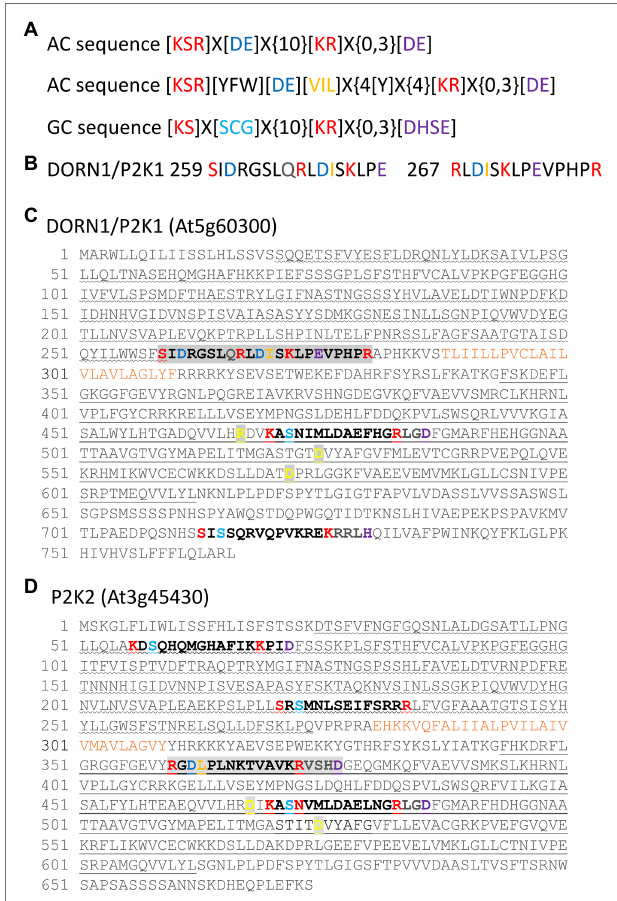
FIGURE 1 | Putative AC and GC sequences in the extracellular ATP (eATP) receptors DORN1/P2K1 and P2K2. (A) Top: The ACPred AC prediction tool sequence (Xu et al., 2018b). “X” denotes any amino acid, and “{}” denotes the number of undetermined amino acids. Centre: The AC catalytic center sequence used by Al-Younis et al. (2021). Bottom: The GCPred GC prediction tool sequence (Xu et al., 2018a). (B) The two extracellular, overlapping putative AC sequences from DORN1/P2K1 shown separately for clarity. (C) Putative AC and GC sequences of DORN1/P2K1. Overlapping AC sequences are highlighted in light gray. The extracellular lectin domain is underlined with a wave, and the intracellular serine–threonine kinase domain is denoted with a straight underline. The transmembrane domain is annotated in ochre. Amino acids found to be important for kinase activity are bold in yellow on a gray background (Choi et al., 2014b; Nguyen et al., 2016; Cho et al., 2017). (D) Putative AC and GC sequences of P2K2. The AC sequence is highlighted in light gray. Domains are identified as for (B) . Amino acids found to be important for kinase activity are bold in yellow on a gray background (Pham et al.,